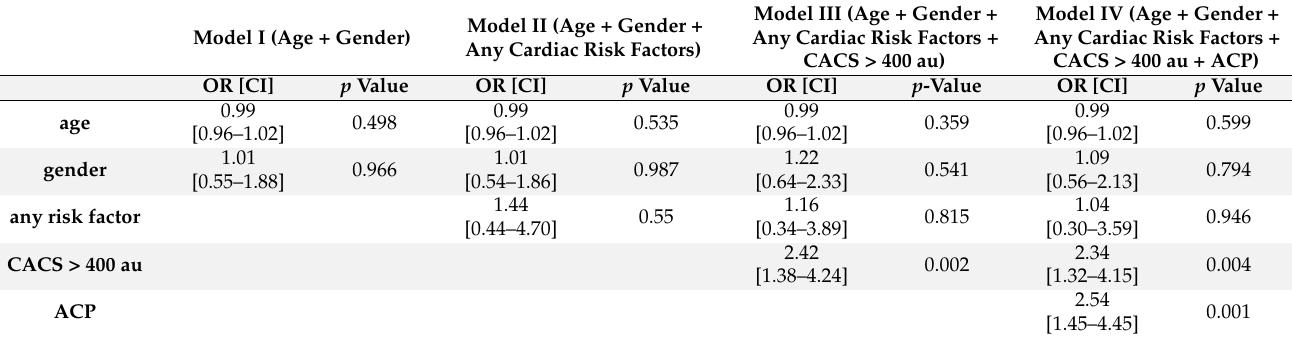
Table 2. Multivariate analysis for predictors of ≥ 70% coronary artery stenosis.